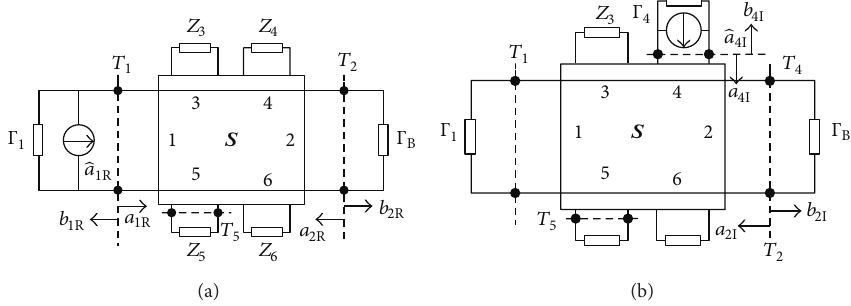
Figure 8: The equivalent circuit model for (a) radiation test and (b) injection test.